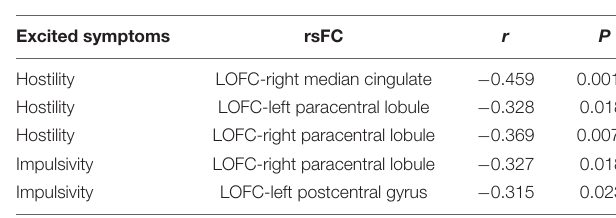
TABLE 7 | Correlations between the rsFC values and PANSS excited subscale scores in patients with FES (after correcting for age, gender, education, and illness